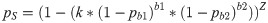
Simulation showing that a disparity in the potency of two monoclonal antibodies diminishes returns from their combination.The equation pS=(1−(k*(1−pb1)b1*(1−pb2)b2))Z is used to simulate the effects of combining two antibodies of markedly different potency (probability of protection parameters pb1 and pb2, using experimentally derived values for P. falciparum CSP-specific monoclonal antibodies 2A10 (b1; pb1 = 0.022) and 5D5 (b2; pb2 = 0.143), where pS is the probability of sterile protection, k the natural infectivity of sporozoites, and Z the number of sporozoites, using Z = 1000 and k = 0.04.